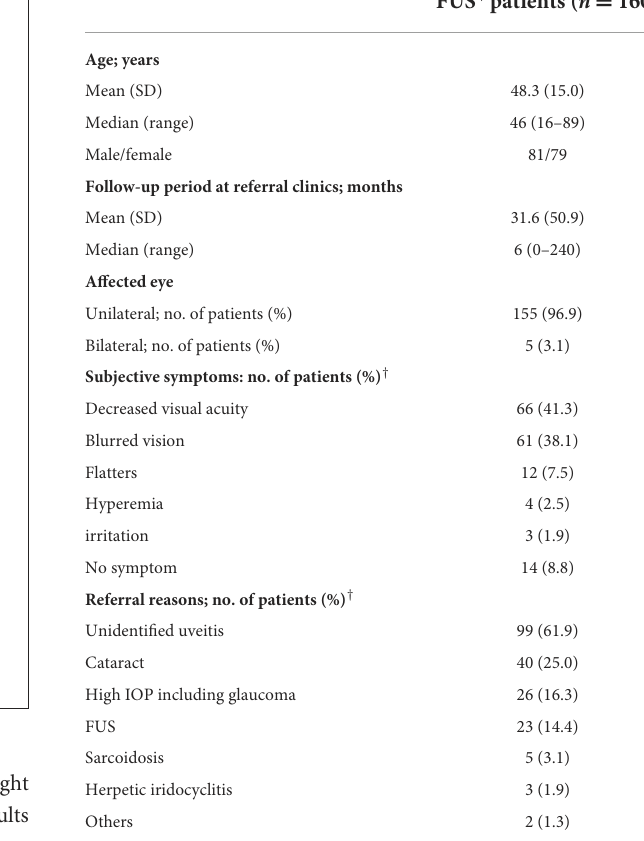
TABLE 1 Background of Fuchs’ uveitis syndrome patients enrolled in this